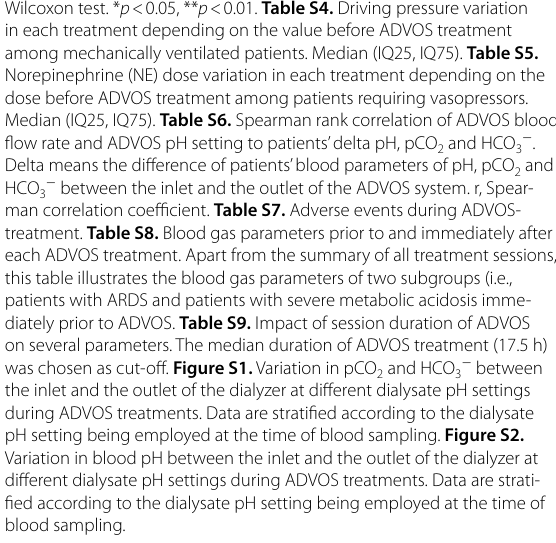
HCO 3 − between the inlet and the outlet of the ADVOS system. r, Spear- man correlation coefficient. Table S7. Adverse events during ADVOS- treatment. Table S8. Blood gas parameters prior to and immediately after each ADVOS treatment. Apart from the summary of all treatment sessions, this table illustrates the blood gas parameters of two subgroups (i.e., patients with ARDS and patients with severe metabolic acidosis imme- diately prior to ADVOS. Table S9. Impact of session duration of ADVOS on several parameters. The median duration of ADVOS treatment (17.5 h) was chosen as cut-off. Figure S1. Variation in pCO 2 and HCO 3 − between the inlet and the outlet of the dialyzer at different dialysate pH settings during ADVOS treatments. Data are stratified according to the dialysate pH setting being employed at the time of blood sampling. Figure S2. Variation in blood pH between the inlet and the outlet of the dialyzer at different dialysate pH settings during ADVOS treatments. Data are strati- fied according to the dialysate pH setting being employed at the time of blood sampling. Abbreviations ACLF: acute-on-chronic liver failure; ADVOS: Advanced Organ Support System; AKI: acute kidney injury; ALF: acute liver failure; ARDS: acute respiratory